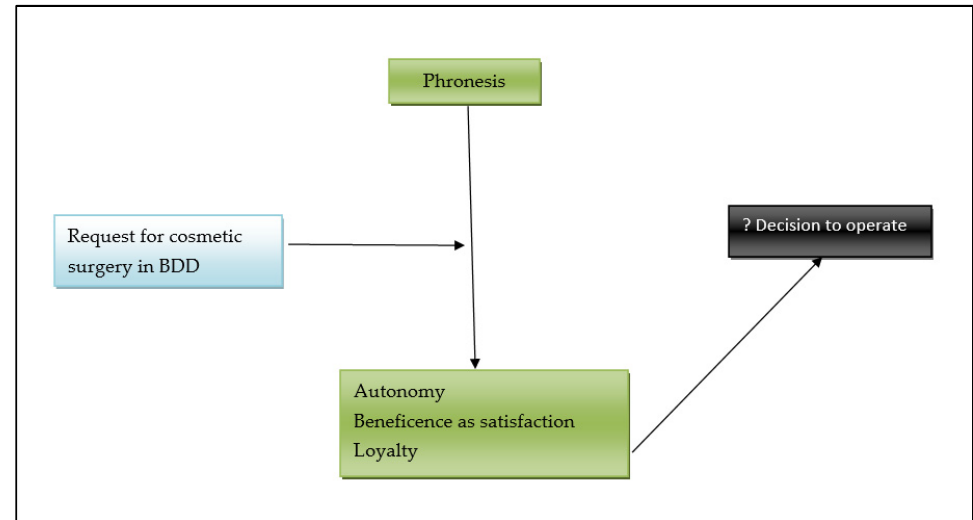
Figure 1. Decision to operate in a case of cosmetic procedure requested by a patient with BDD.